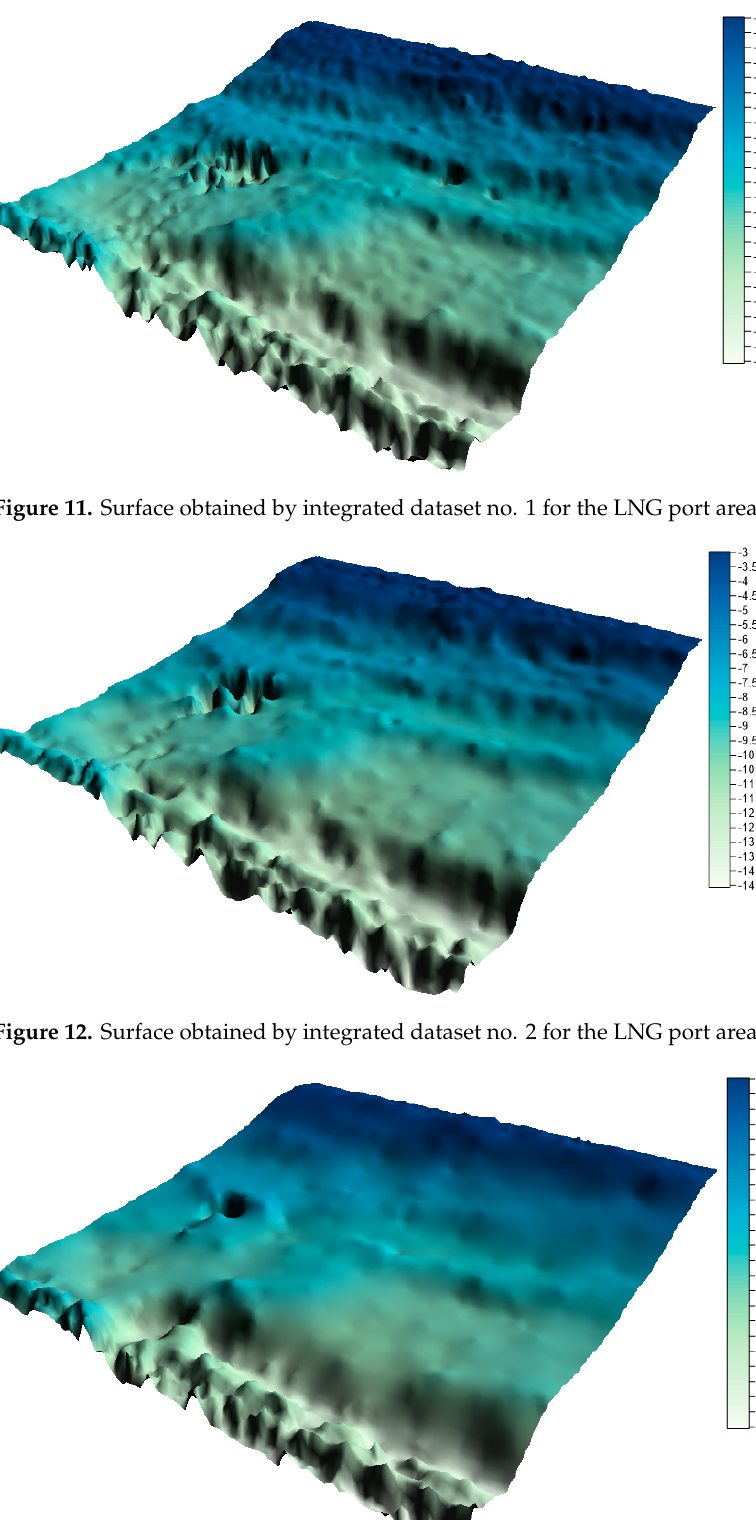
Figure 10. Reference surface for the LNG port area.